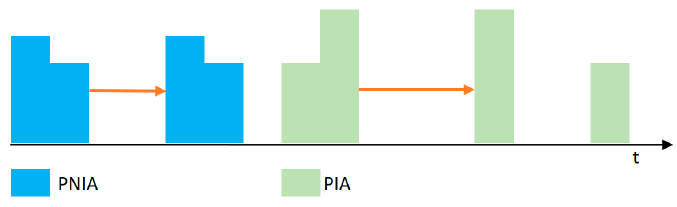
Figure 4. Types of programmable appliances.